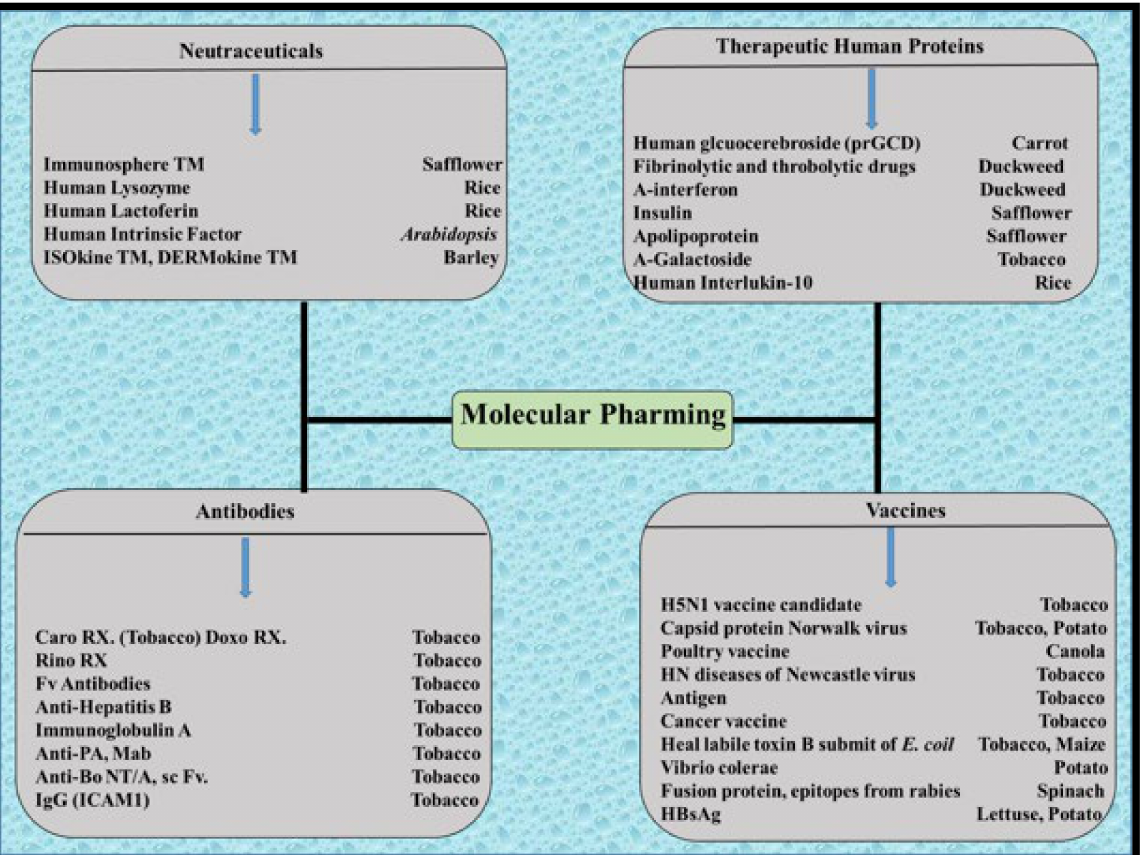
Figure 4. Plant molecular pharming products in different